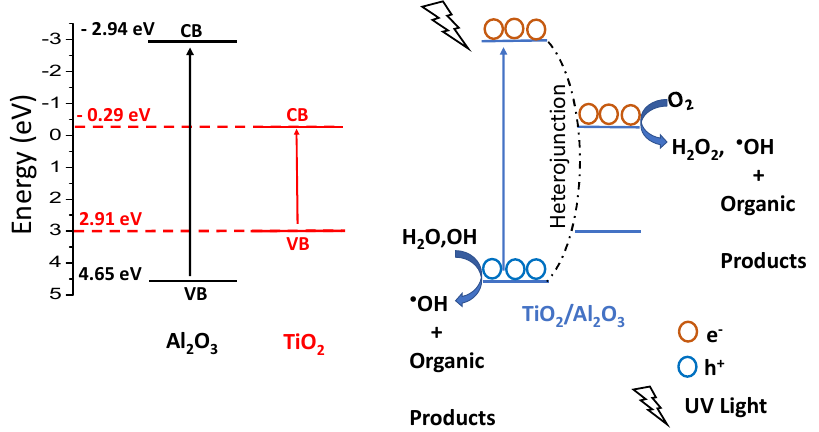
Figure 10. Band diagram for γ -Al 2 O 3 with TiO 2 catalysts.